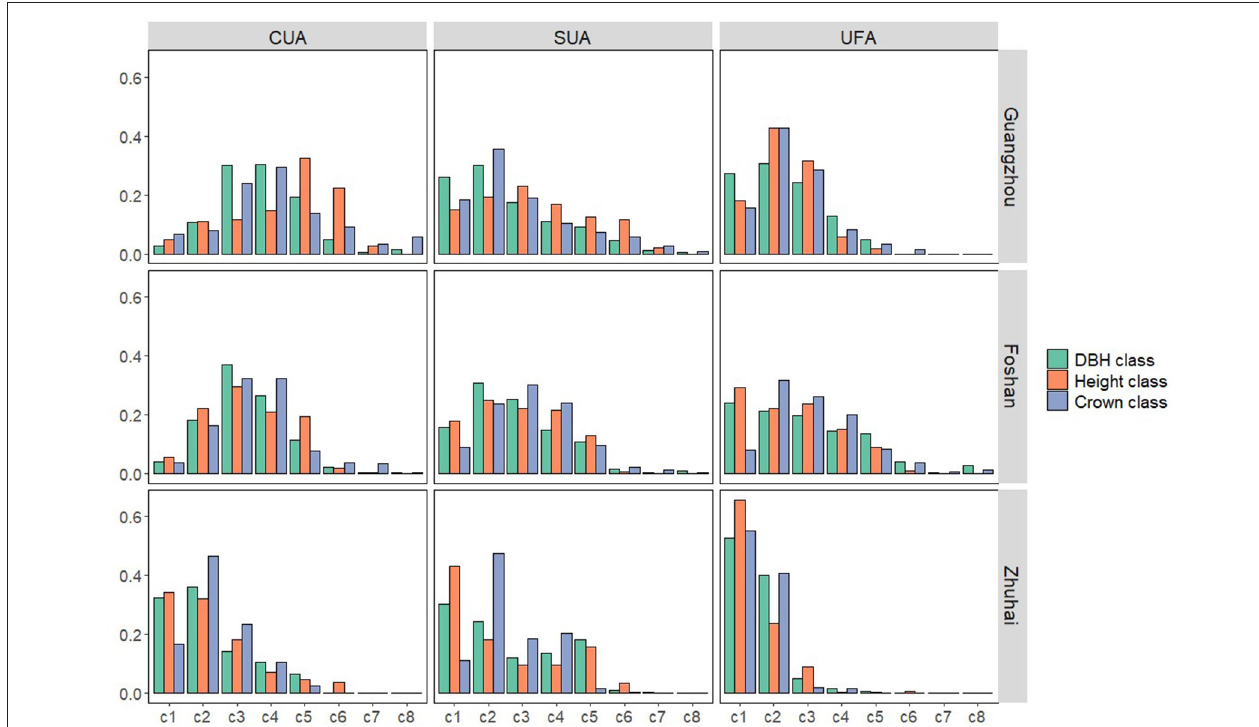
FIGURE 3 | Distributions of the classes of DBH (green bars), height (orange bars), and crown (cyan bars) of CUA, SUA, and UFA in each city. The classified classes from c1 to c8 are on the x-axis and the numbers on the y-axis represent the percentages of the classes.